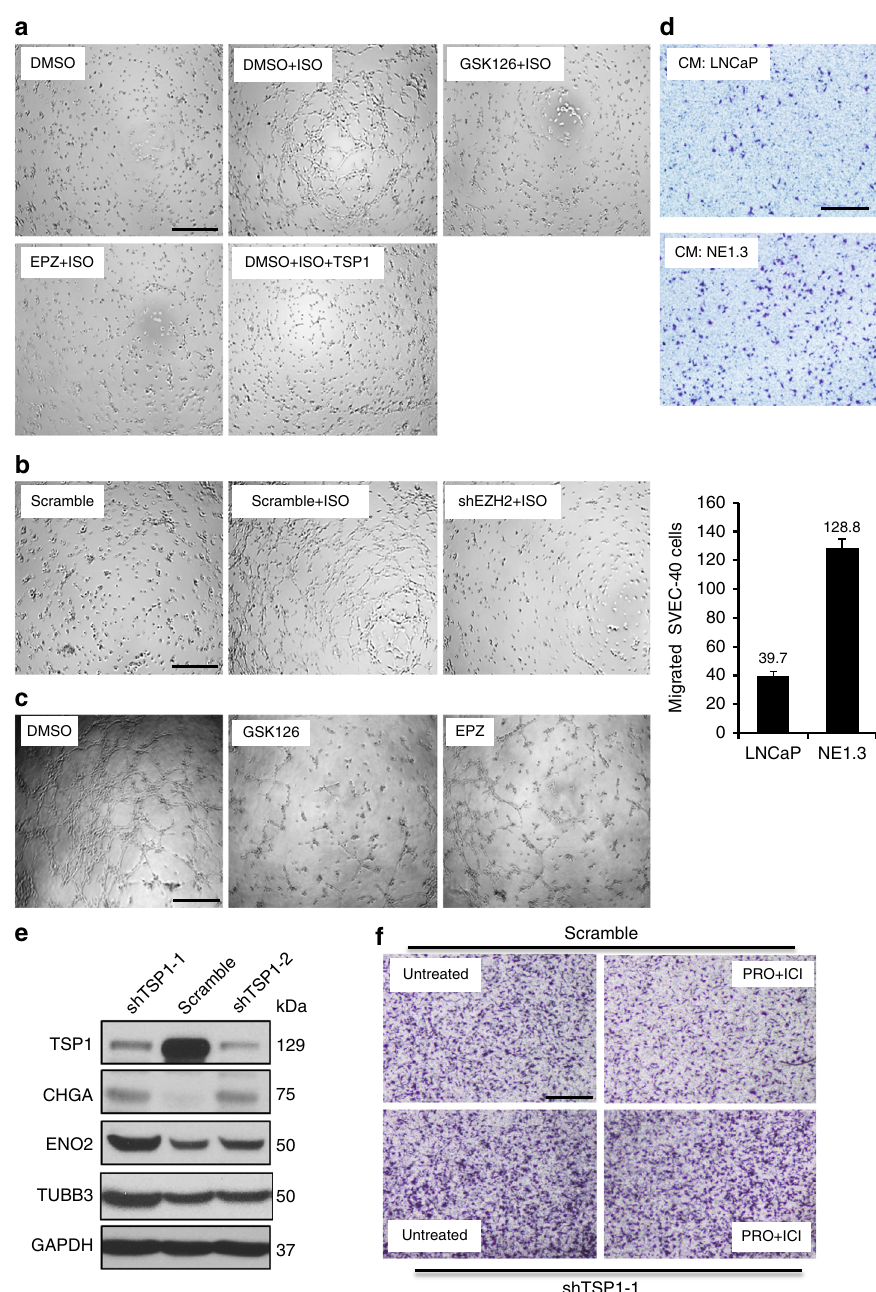
Fig. 9 CREB activation induces angiogenesis in vitro, depending on the EZH2/TSP1 axis. a Serum starved PC3 cells were treated with 10 μ M ISO with or without 5 μ M EZH2 inhibitor GSK126 or EPZ6438. Conditioned media (CM) from the PC3 cells were then used to culture serum starved SVEC-40 endothelial cells seeded on growth factor reduced Matrigel for angiogenesis tube formation assay. TSP1 peptides were added to 10 μ M of fi nal concentration to the SVEC-40 cells in conditioned media from ISO-treated PC3 cells. The assays have been done at least twice with similar results. b Conditioned medium from ISO-treated PC3 cells with EZH2 knockdown can not induce angiogenesis tube formation of SVEC-40 endothelial cells. c Conditioned medium from NE1.3 cells treated with 5 μ M EZH2 inhibitor EPZ6438 or GSK126 were used in SVEC-40 tube formation assay. d Conditioned medium from serum starved LNCaP and NE1.3 cells was used as attractants for migration of SVEC-40 cells in Boyden Chamber migration assay. Representative pictures from two experiments are shown. e Western blotting of TSP1 and NE markers in PC3 expressing scramble shRNA or two independent TSP1 shRNAs. f Endothelial SVEC-40 migration assay with attractants of conditioned medium from PC3-scramble or PC3-shTSP1 cells, either mock treated or treated with 10 μ M PKA/CREB signaling inhibitors PRO and ICI for 48h. Representative pictures from two experiments are shown. Scale bar = 100 µ CREB repression blocks castration-activated EZH2/TSP1/NE (Fig. 9f). Taken together, these results support our hypothesis that pathway and angiogenesis . We have previously shown that beta adrenergic signaling induces angiogenesis and NE phenotype through the CREB/EZH2/TSP1 pathway. treatment with beta adrenergic agonist, ISO, promotes tumor